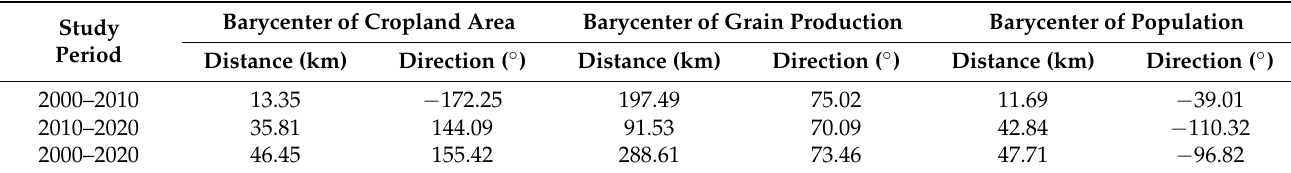
Table 2. Moving distances and directions of